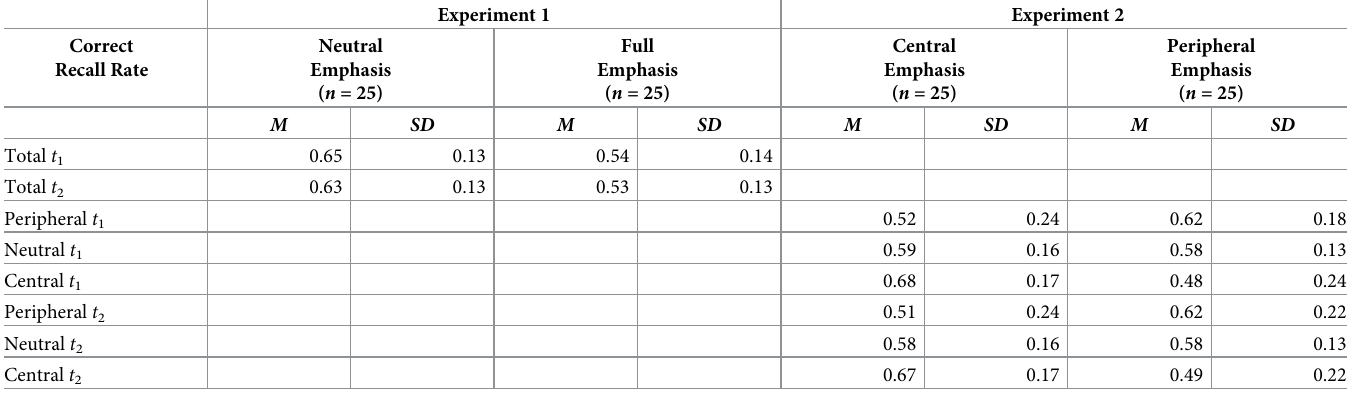
Table 5. Correct recall rates for GGSS-1 items as a function of emphasis and item types across